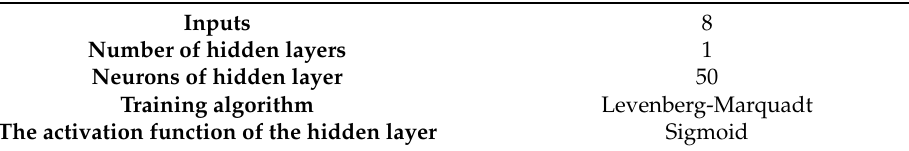
Figure 7. Advance Script. The network parameters undergo some modifications. At line 26, another hidden layer is added, as shown in Figure 8 , with 10 neurons to see whether the error will be reduced or not.